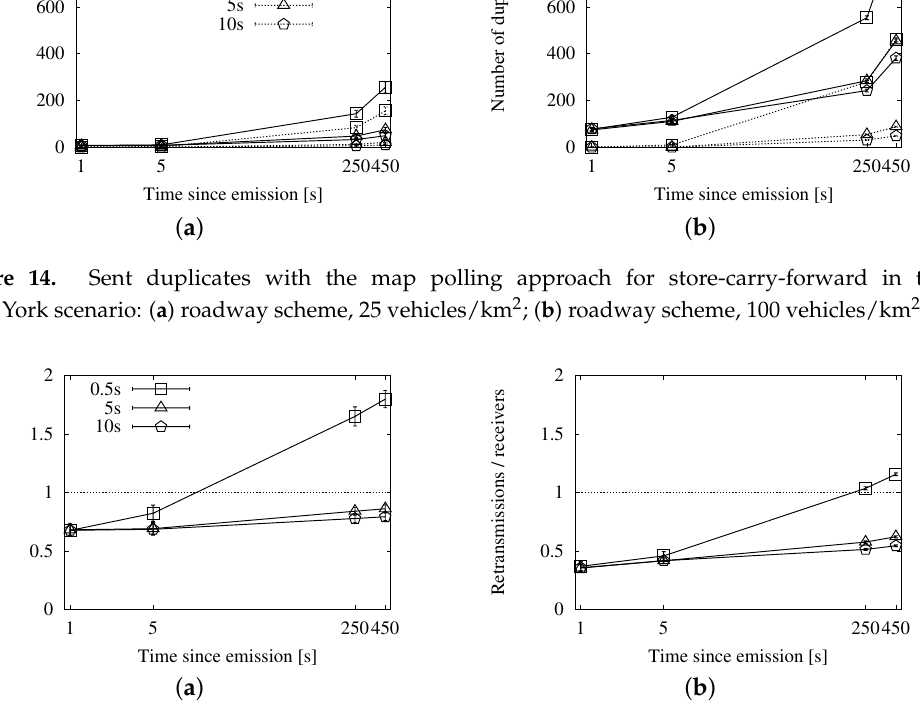
Figure 15. Forwarding ratio or the relation between sent messages and receivers with the map polling approach for store-carry-forward in the New York scenario: ( a ) roadway scheme, 25 vehicles/km 2 ; ( b ) roadway scheme, 100 vehicles/km 2